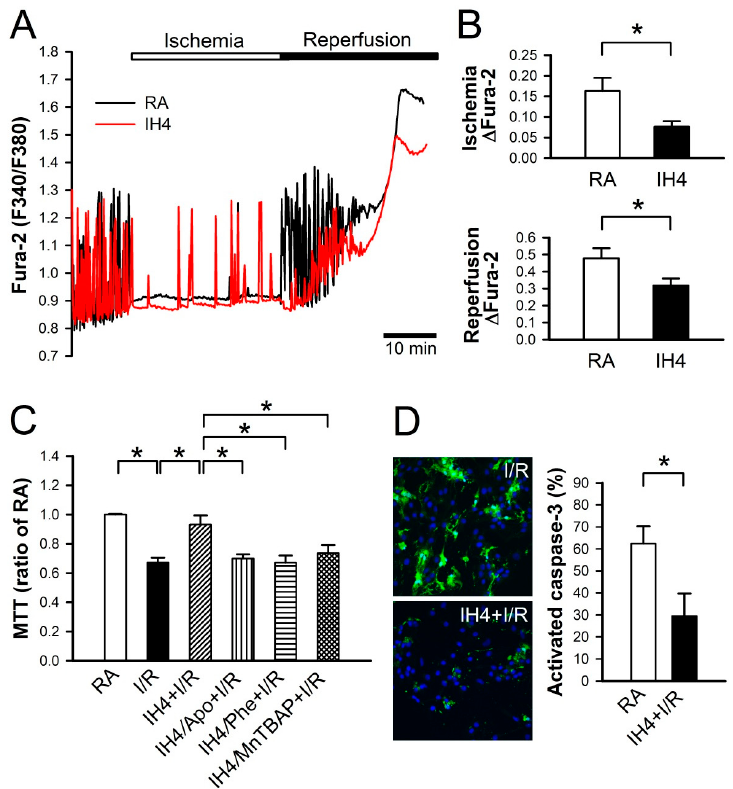
Figure 5. Effects of IH on the I/R-induced cytosolic Ca 2+ increases and cell death. ( A ) The time course of cytosolic Ca 2+ changes in cardiomyocytes perfused with ischemic and reperfusion buffer to mimic I/R injury, and recorded by a real-time fluorescence imaging system. Treatment of cardiomyocytes to IH for four days attenuated the ischemia and reperfusion-induced increases of cytosolic Ca 2+ level. ( B ) The difference between the baseline and plateau of Fura-2 (F340/F380) was defined as Δ Fura-2. The quantitative results show that the ischemia and reperfusion-increased cytosolic Ca 2+ was significantly lower in cardiomyocytes treated with IH4 than with RA. Data represent the means ± SEM. n = 4 for each group. * p < 0.05. ( C ) Neonatal cardiomyocytes were treated with IH for four days, and then co-treated with IH and antioxidant, Apo, Phe or MnTBAP, followed by I/R treatment. Treatment with IH4 prevented the I/R-induced cell death. However, co-treatment with Apo, Phe or MnTBAP abolished the IH-prevented cell death. Data represent the means ± SEM. n = 5 for each group. * p < 0.05. ( D ) The left panel shows the representative images of activated caspase-3 expression detected by CaspGLOW fluorescein active caspase-3 staining kit after I/R treatment. The right panel gives the quantitative results, showing that the expression of active caspase-3 was significantly lower in cardiomyocytes treated with I/R + IH4 than with I/R + RA. Data represent the means ± SEM. ( n = 14). * p < 0.05. I/R, ischemia/reperfusion.